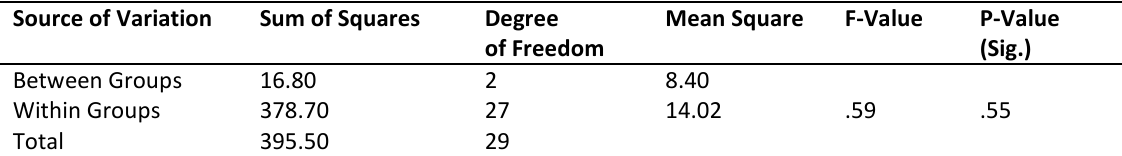
Figure 2. Graphical representation of mean scores with regard to judo, taekwondo and boxing players on the sub-parameter preparation Table 10. One way analysis of variance (Anova) results among judo, taekwondo and boxing players with regard to the sub-parameter game/competition